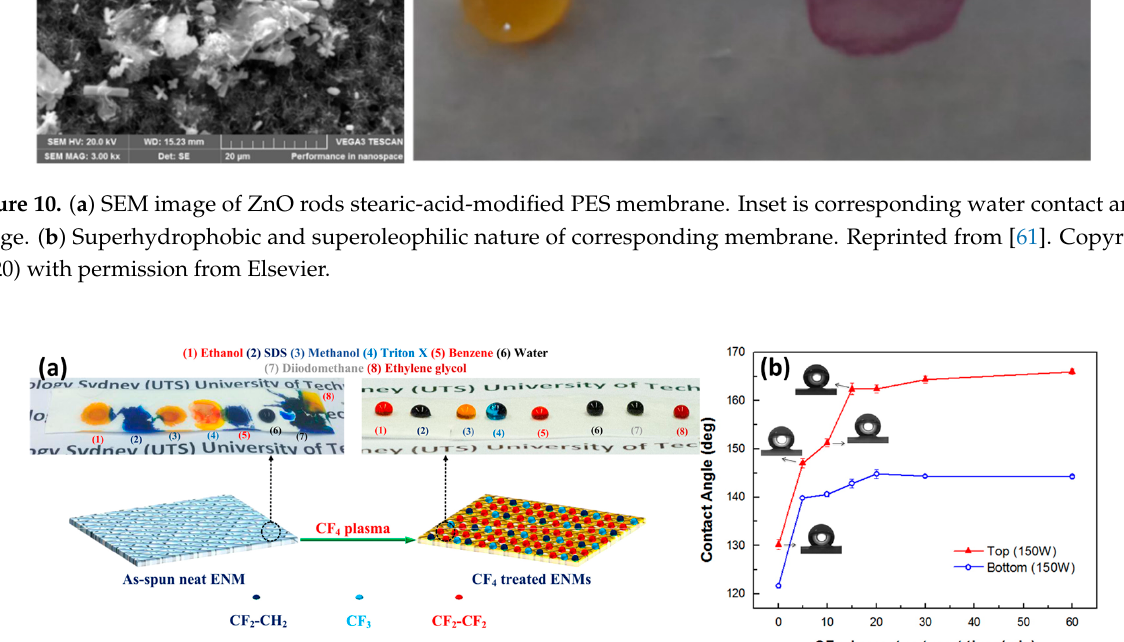
Figure 11. ( a ) Schematic illustrations of the neat and CF 4 plasma-modified electrospun nanofiber membranes. Reprinted from [66]. Copyright (2017) with permission from Elsevier. ( b ) Water contact angles of top/bottom PVDF membrane surface as a function of CF 4 plasma treatment time. Reprinted from [64]. Copyright (2014) with permission from Elsevier.